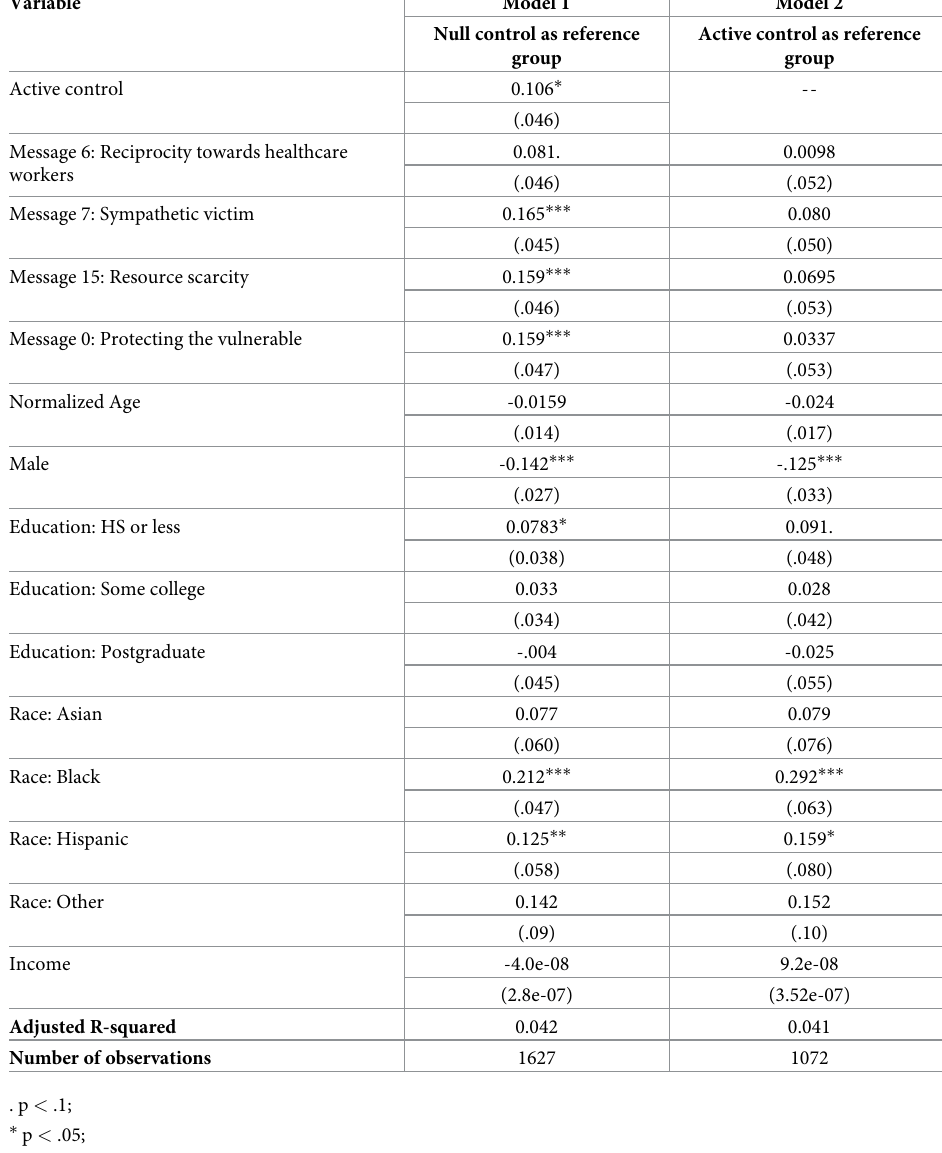
Table 2. Regression from Study 1, aggregate difference score as